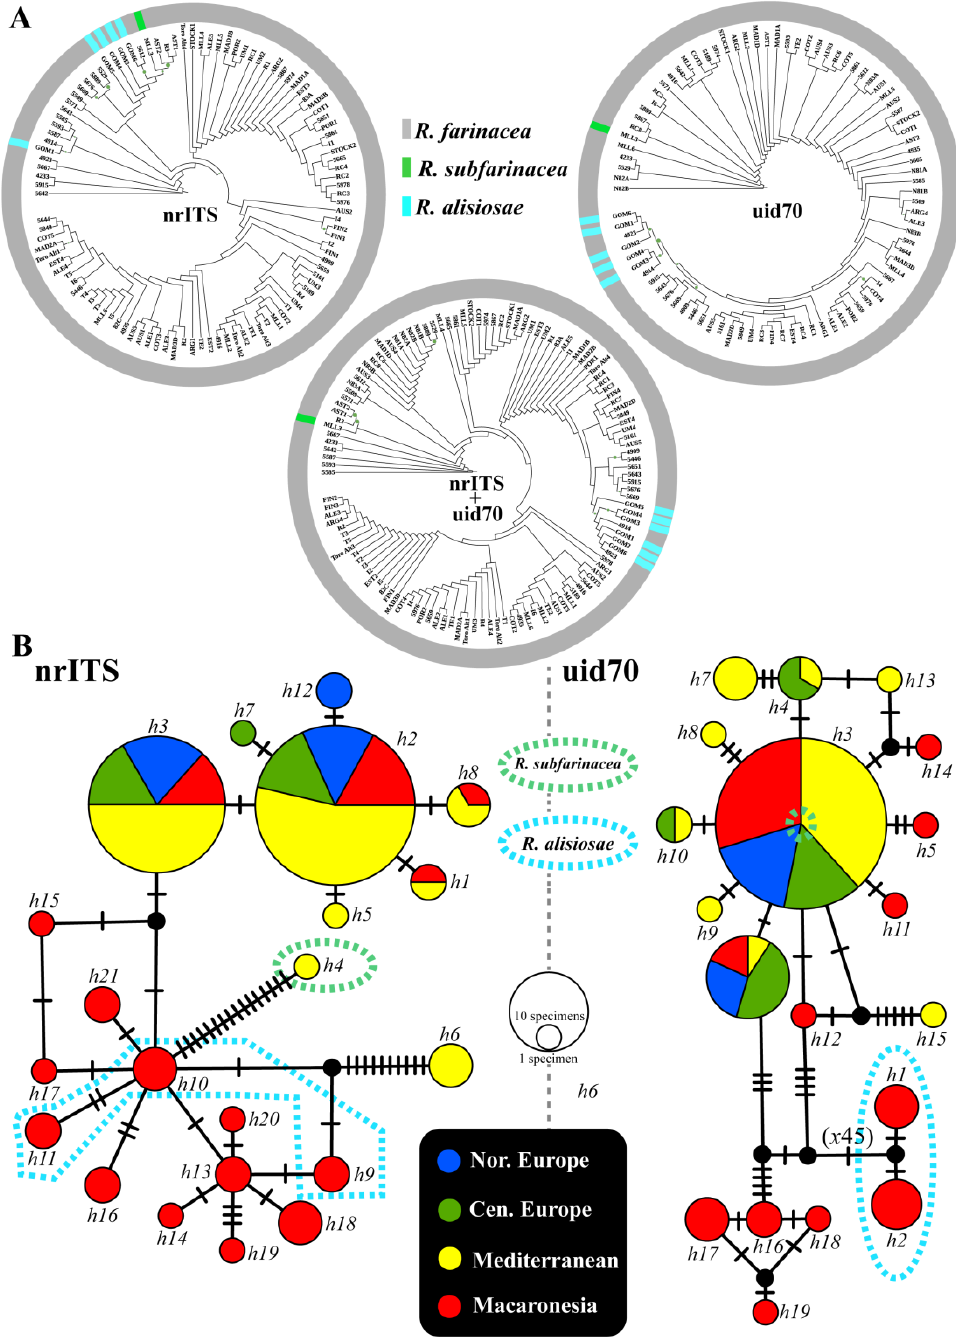
Figure 1. ( A ) Single- and two-locus circular phylograms estimated with RAxML showing the relationships among the specimens of Ramalina farinacea (grey-colored tips) and those of the closely related species R. alisiosae (blue-colored tips) and R. subfarinacea (green-colored tips); note that, for the sake of clarity, tree representation ignored branch lengths; minute green dots on nodes denote nodal support (BS ≥ 70%); ( B ) Statistical parsimony networks for nrITS and uid70; circle colors indicate the geographic regions where specimens were collected (see legend below) whereas green and blue dashed lines indicate specimens identified as Ramalina species other than R. farinacea ; the sizes of circles in each network are proportional to the numbers of individuals bearing the haplotype; circles may represent two or more haplotypes when these are separated only by indels; black-filled circles indicate missing haplotypes, and hatch marks indicate mutations.